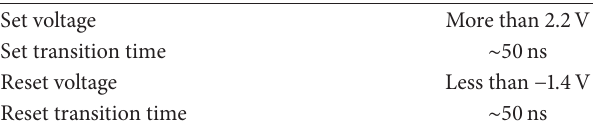
Table 2: ReRAM device characteristics [11].